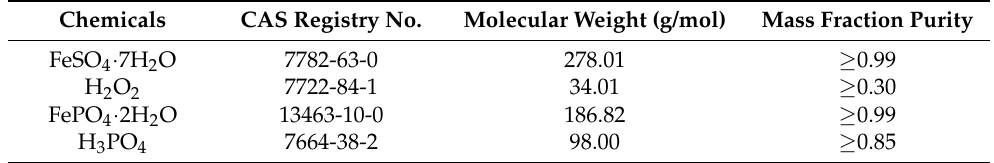
Table 1. Detail of the materials specification.